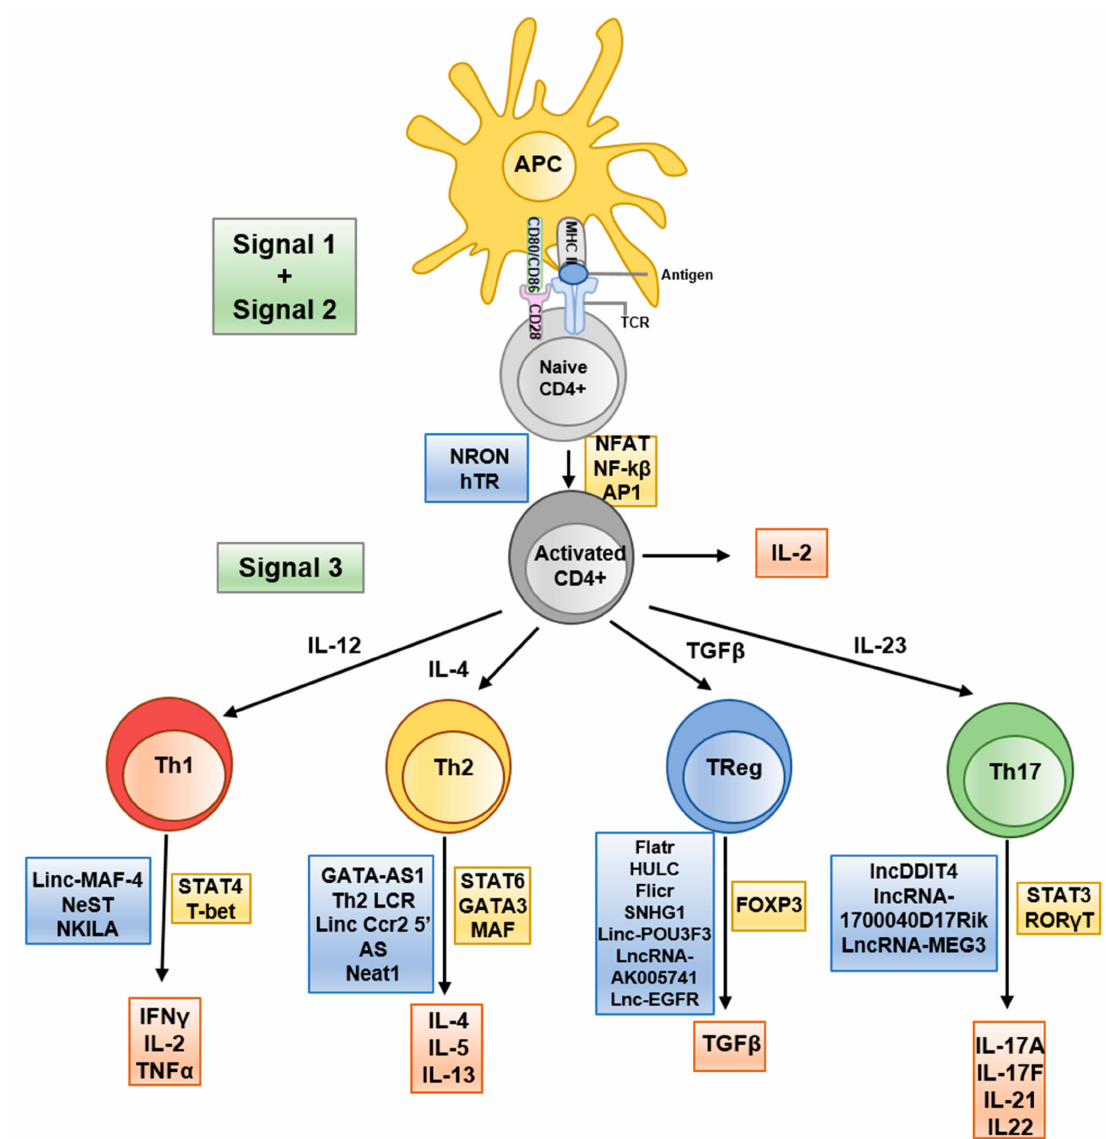
Figure 1. Schematic representation of T helper di ff erentiation and associated lncRNA. Key secreted cytokines (red boxes), transcribed transcription factors (yellow boxes) and implicated lncRNAs (blue boxes) are indicated at the appropriate transitional